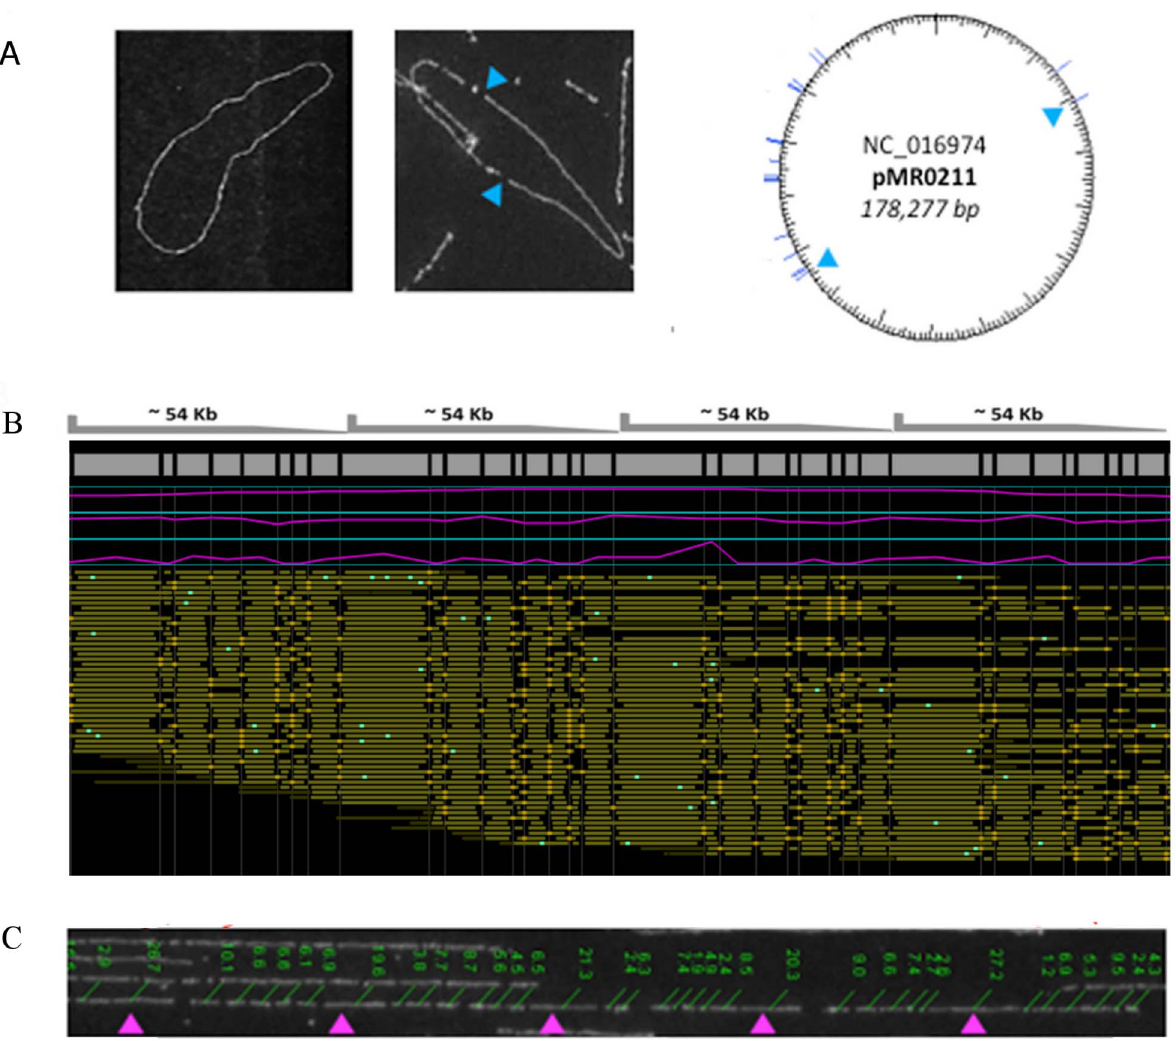
Figure 4. Whole genome mapping of two extra-chromosomal DNA elements in Providenciastuartii MRSN 2154. ( A ) A large circular plasmid with its estimated size ( . 160 kb) and NcoI pattern consistent with the bla NDM-1 plasmid carried by MRSN 2154. Left , the plasmid prior to NcoI digestion (QCard image); center , the NcoI-digested plasmid (MapCard image); right , the in silico NcoI restriction map for the bla NDM-1 plasmid. ( B ) A novel putative bacteriophage coexisting with MRSN 2154. The Consensus WGRM assembled for the bacteriophage suggests a repetitive structure; each repeat is approximately 54 kb in size. ( C ) Sized image of one of the DNA molecules from the bacteriophage assembly. The 20 kb NcoI fragments are indicated with the arrows in the